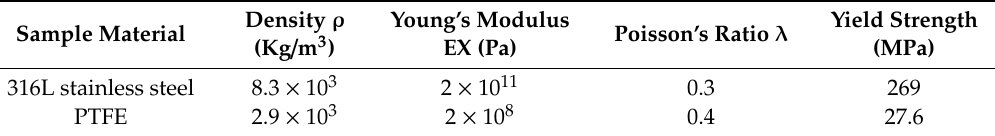
Table 1. The material properties of 316L stainless steel and PTFE.